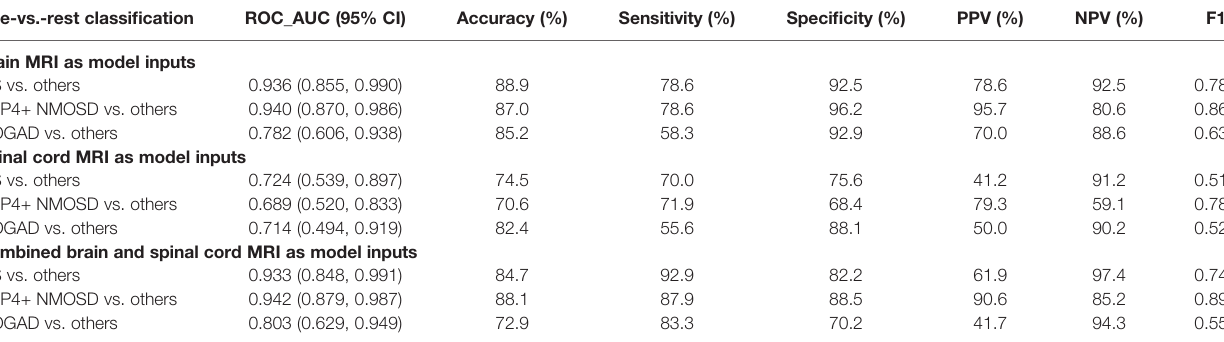
TABLE 2 | Diagnostic performance of our proposed MIL-CoaT transformer model based on different inputs in classi fi cation of MS, AQP4+ NMOSD and MOGAD. One-vs.-rest classi fi